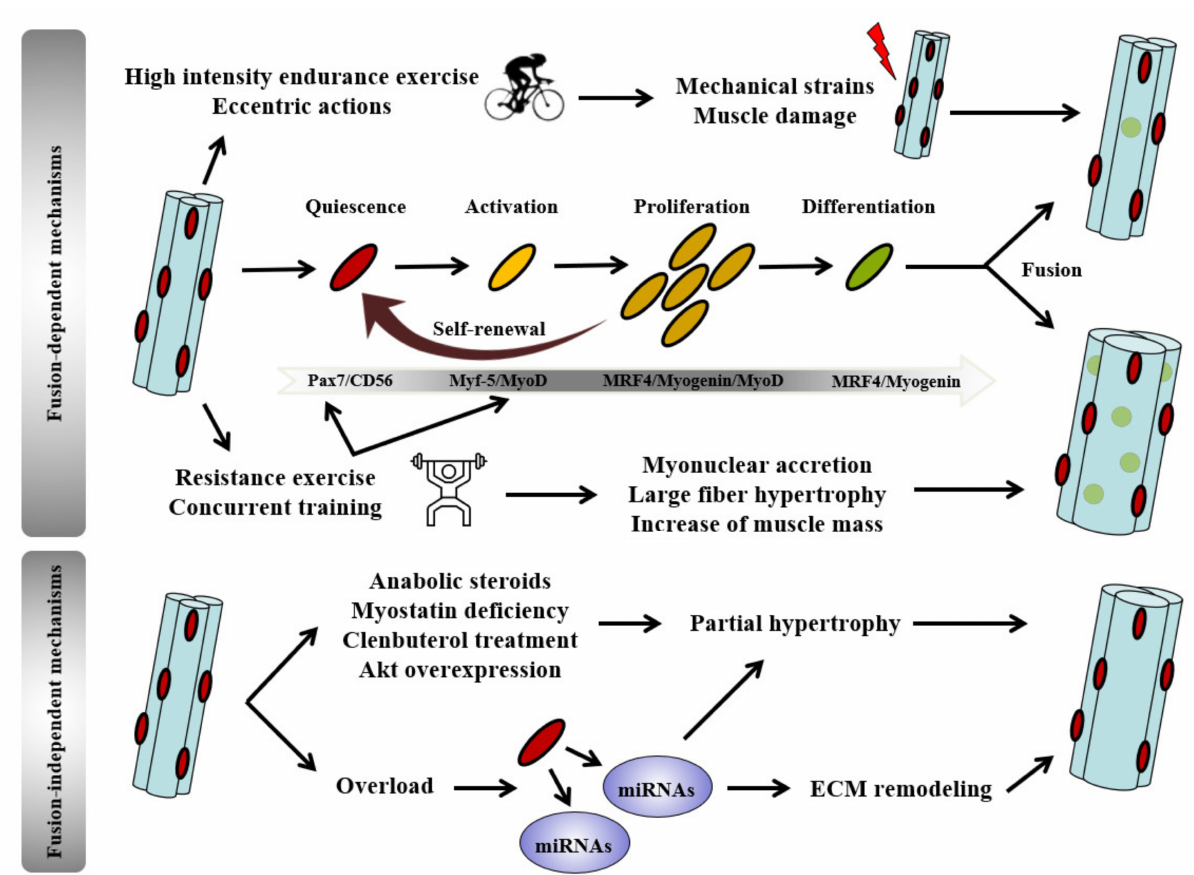
Figure 4. Fusion-dependent and independent mechanisms of satellite cells during growth stimuli. Adult satellite cells (SCs) are in a quiescent state, expressing Pax7 (paired box protein 7) and CD56 (cluster of differentiation 56). Activation of SCs sets off the progression of myogenic lineage from quiescence to fusion. It requires MRF (myogenic regulatory factors) such as Myf-5 (myogenic factor 5), MyoD (myoblast determination protein D), myogenin, and MRF4 (myogenic regulatory factor 4). Whereas damaging exercises (high intensity endurance and eccentric contractions) promote SCs fusion in a regeneration process, exercise-induced hypertrophy requires SCs fusion and myonuclear accretion to increase fiber size. However, fusion-independent mechanisms may promote partial hypertrophy. The secretory functions of SCs seem to play a role in these mechanisms and in ECM (extracellular matrix) remodeling through miRNA-containing exosomes